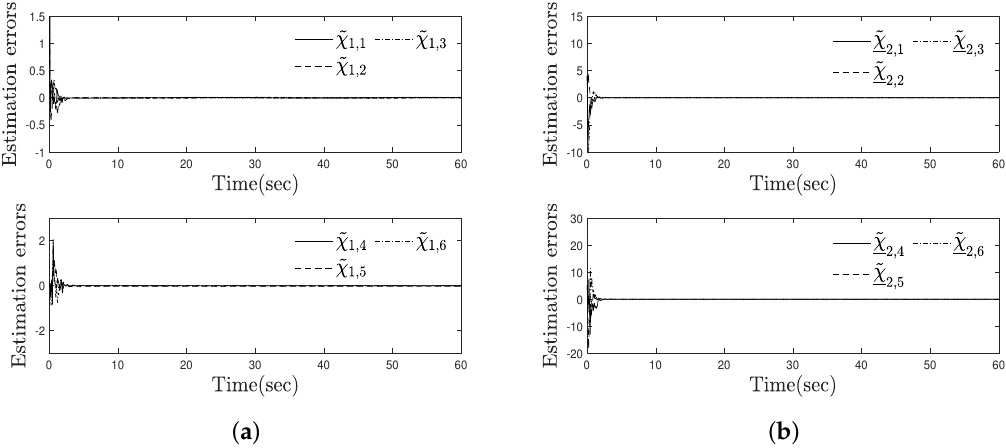
Figure 11. State estimation errors for Scenario 2 ( a ) ˜ χ 1,1 , ˜ χ 1,2 , ˜ χ 1,3 , ˜ χ 1,4 , ˜ χ 1,5 , and ˜ χ 1,6 ( b ) ˜ χ